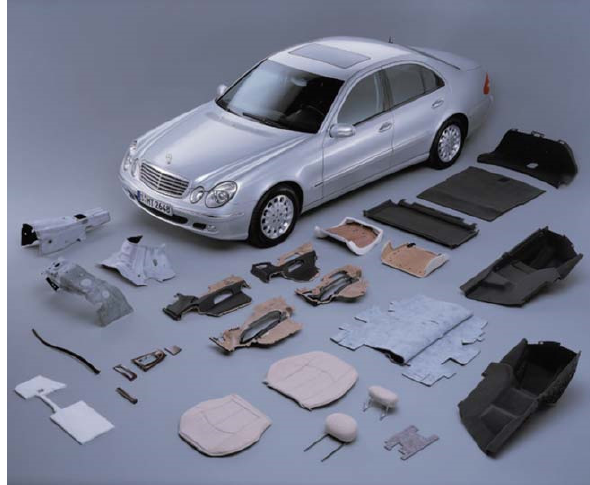
Figure 1. Examples of biocomposite applications in automobiles containing flax, hemp, sisal, and wool [26].